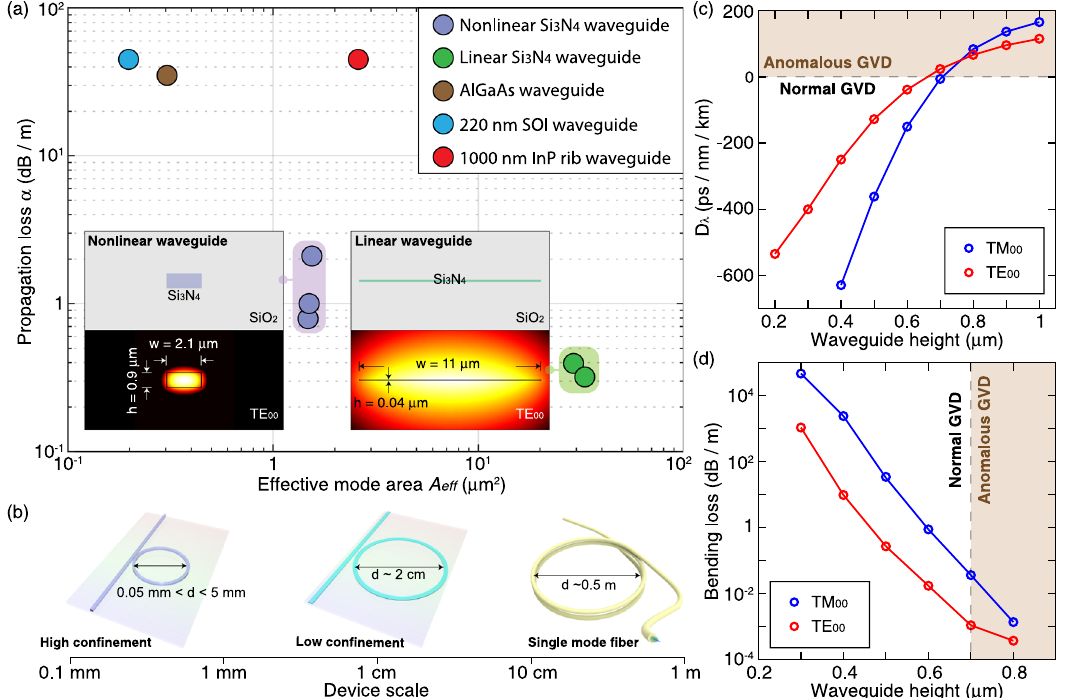
Fig. 1 Comparison of ultralow-loss linear and nonlinear Si 3 N 4 platforms with state-of-the-art silicon, InP and AlGaAs platforms. a Comparison of optical losses and effective mode areas (in the telecommunication band of 1550nm) in state-of-the-art, low-loss waveguides, including nonlinear (i.e. thick-core, refs. 24,25 and this work) and linear (i.e. thin-core, refs. 49,50 ) Si 3 N 4 waveguides, 220nm silicon-on-insulator (SOI) waveguides 54 , 1000nm InP rib waveguides 55 , and nonlinear AlGaAs waveguides 35 . The insets show the waveguide geometry and optical mode pro fi le of the Si 3 N 4 waveguides. b Comparison in device size for linear and nonlinear Si 3 N 4 waveguides and single-mode fi bers. c Simulated GVD parameter D λ as a function of the waveguide height h , with a fi xed waveguide width of w = 2.1 μ m. d Simulated bending loss as a function of the waveguide height h , with a fi xed bending radius of d /2 = 25 μ m and waveguide width of w = 2.1 μ m. Anomalous-GVD region is brown-shaded, which is accessed with h >700nm. The wavelength studied here is